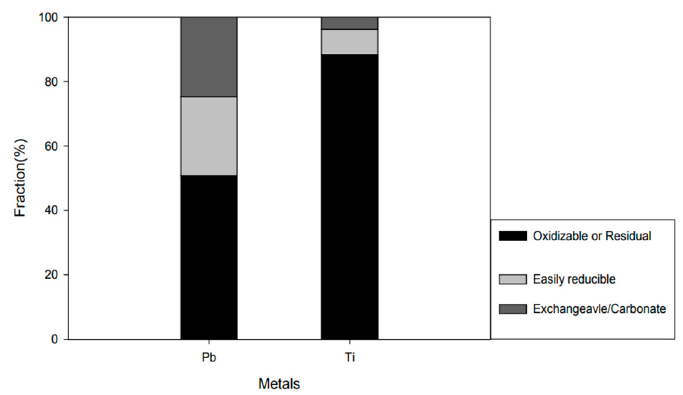
Figure 2. Heavy metal concentration in